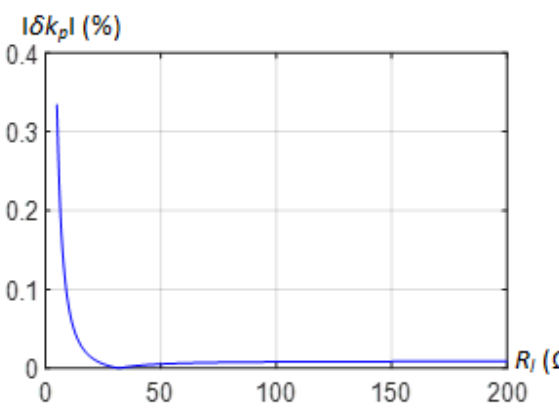
Figure 7. Error dependence on the load resistance 𝑅 𝑙 .